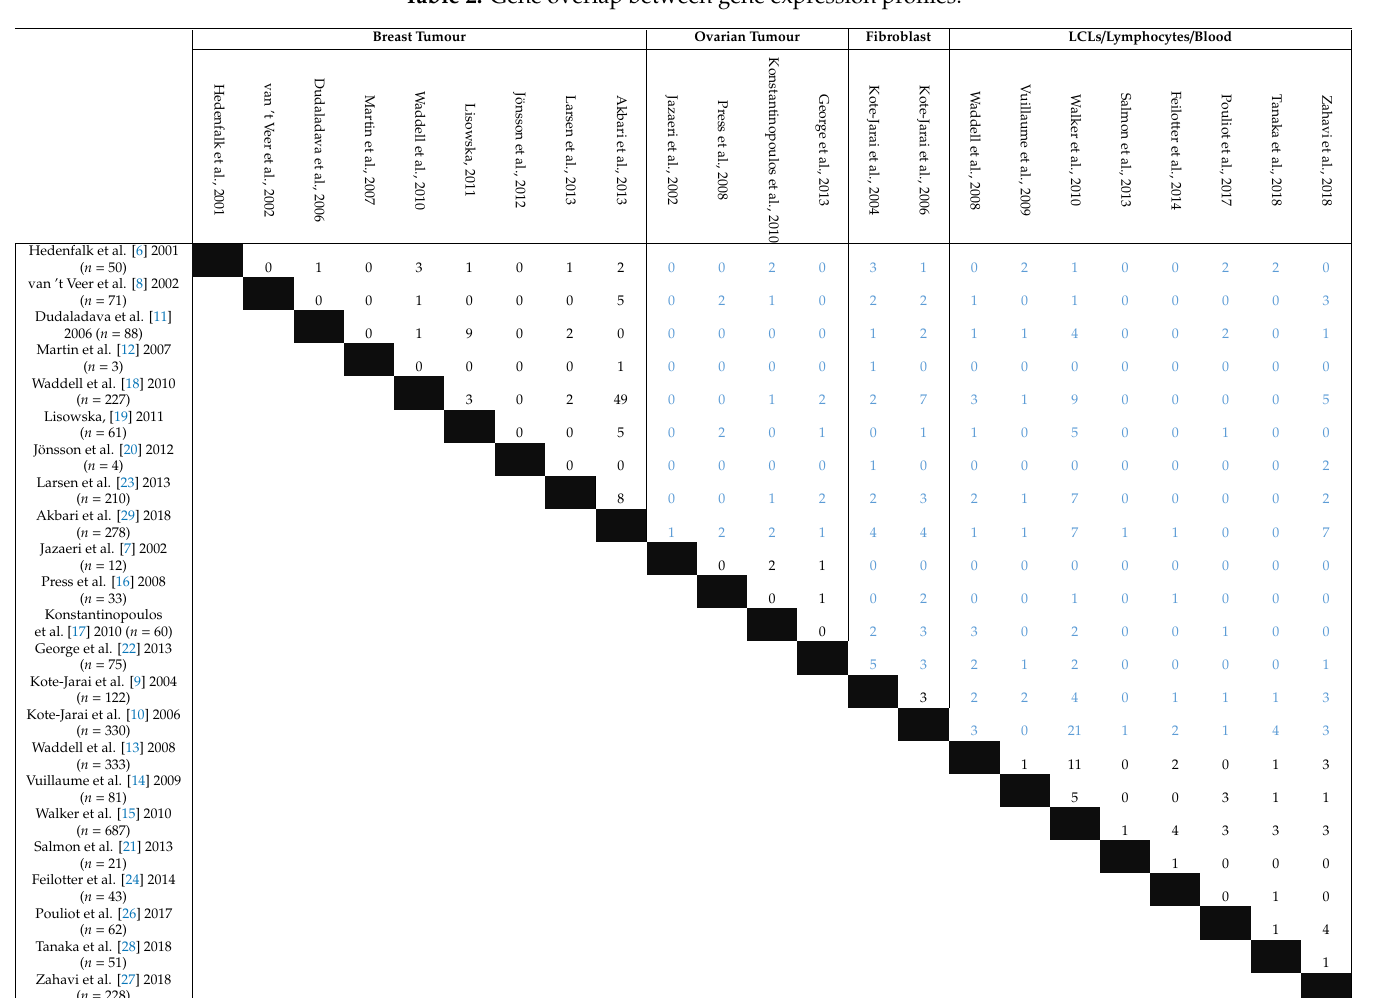
Table 2. Gene overlap between gene expression profiles.